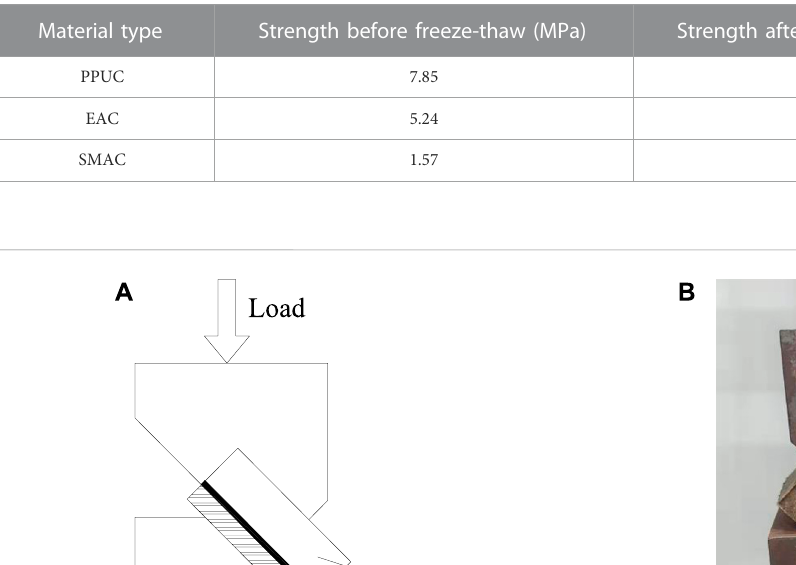
TABLE 4 The results of the freeze-thaw splitting test.